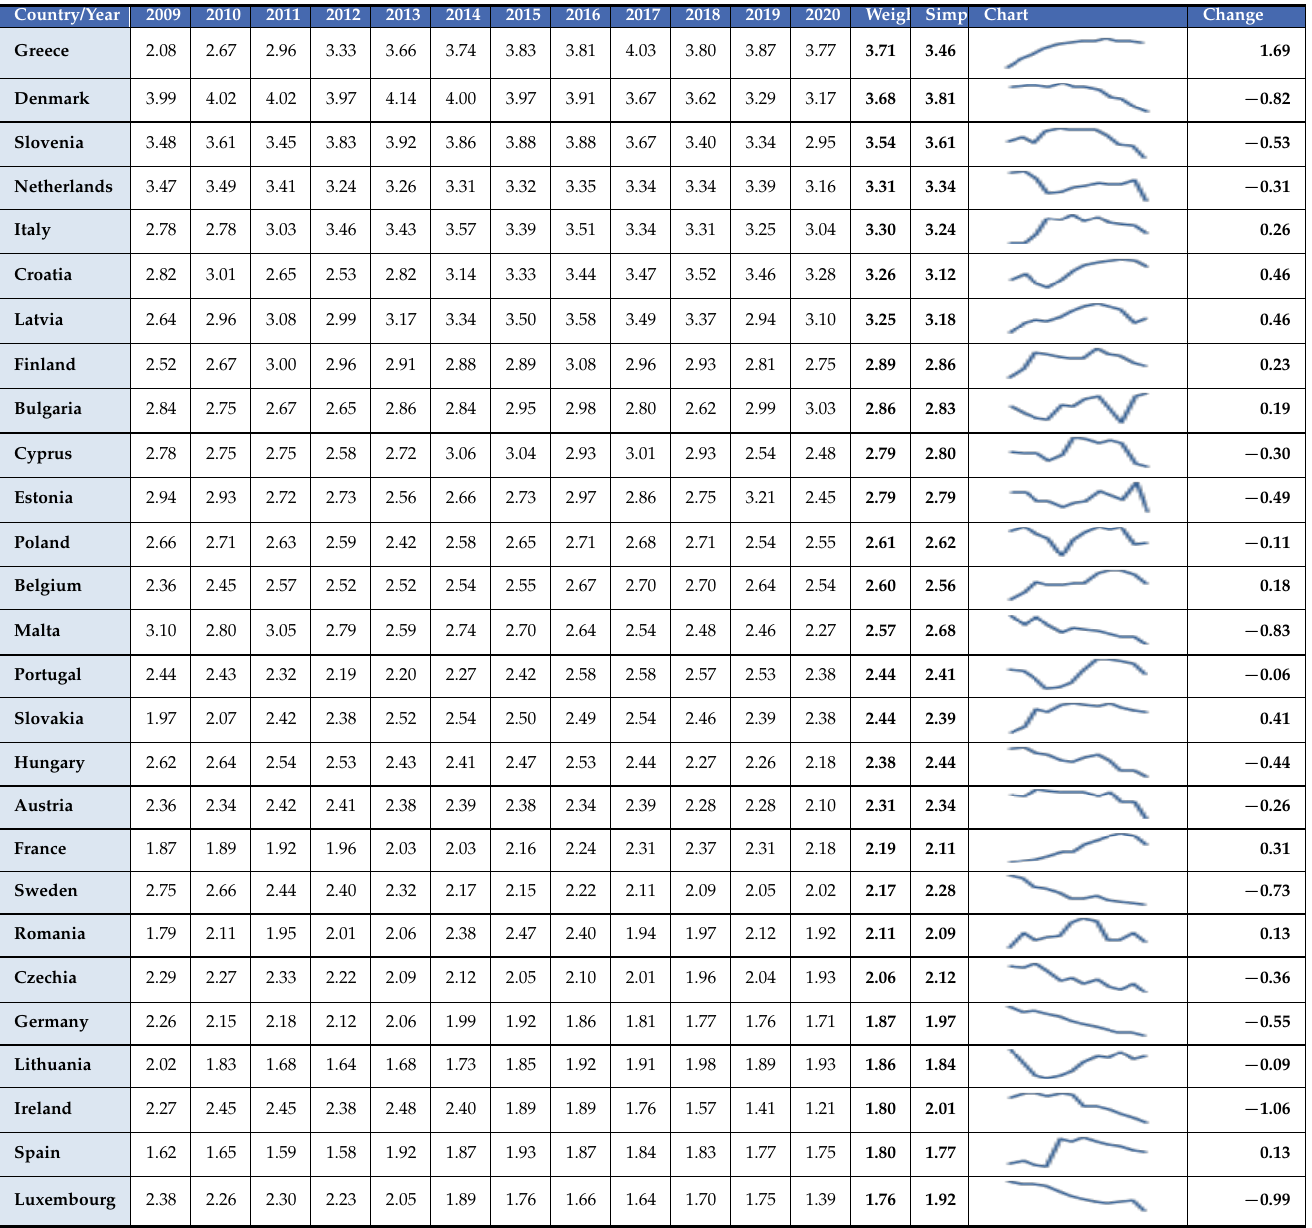
Table 1. Ranking of the EU27 based on the criterion of the weighted average level of the share of environmental tax revenues in GDP in 2009 – 2020 (source: own study).